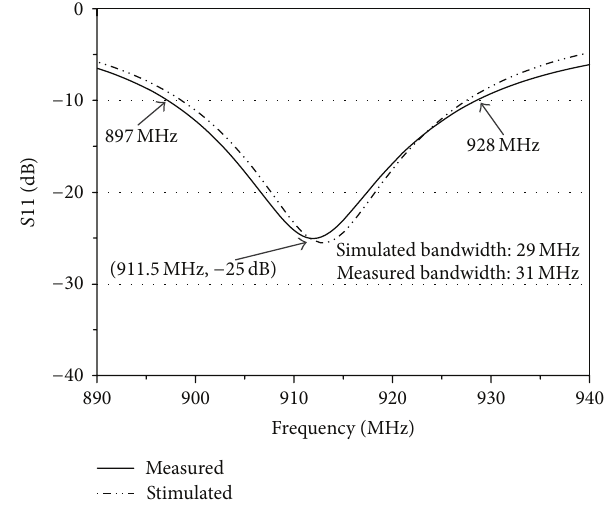
31 mm 2 , as a coin of one CNY. The simulated and measured matching bandwidth of the proposed antenna is shown in Figure 6. There is good agreement between simulation and measurement. The measured bandwidth of the prototype is 31 MHz (897–928 MHz), under the condition of reflection coefficient less than − 10 dB. It completely covers the USA RFID band (902–928 MHz).